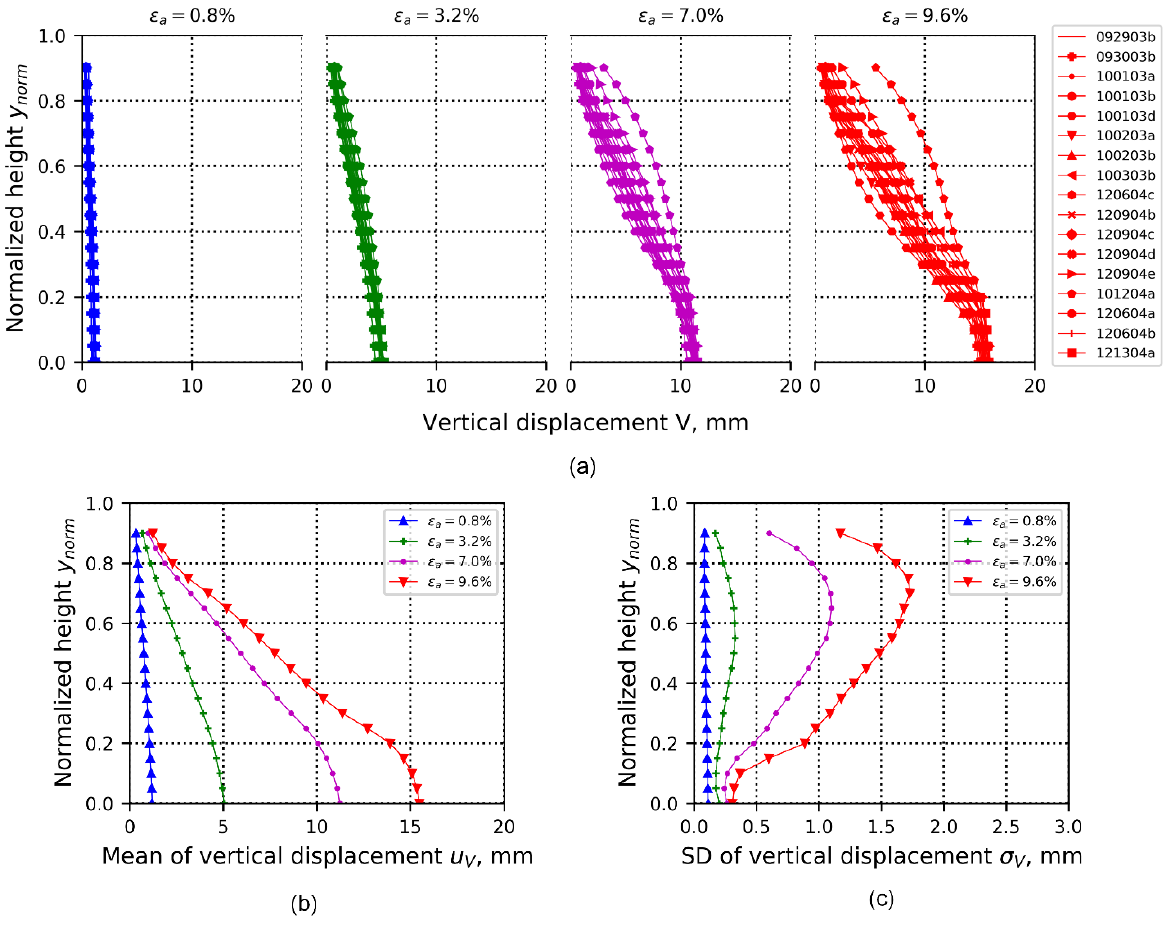
Figure 6. ( a ) Averaged vertical data ensembles calculated from 17 tests at four loading stages—0.8%, 3.2%, 7.0%, and 9.6% of axial strain—for 1D-T data ensembles. The vertical displacement at each specimen height is estimated through averaged vertical displacements that are captured by 3D-DIC. ( b ) Mean profiles of data ensembles of averaged vertical displacements shown in ( a ). ( c ) Standard- deviation profiles of data ensembles of averaged vertical displacements shown in ( a ).